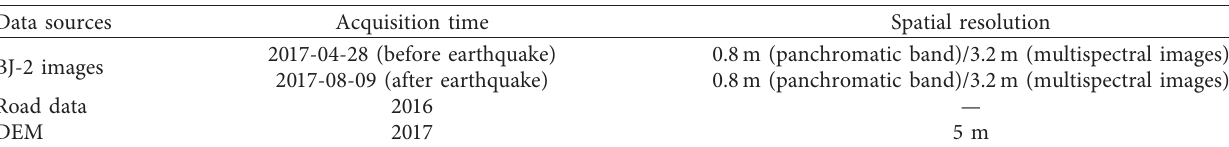
Figure 2: The situation before and after the earthquake in the study area. (a) The BJ-2 satellite image on April 28, 2017, before the earthquake. (b) The BJ-2 satellite image on August 9, 2017, after the earthquake. (c) Field survey figure of the landslide. (d) Field survey figure of road damage. Table 1: Data